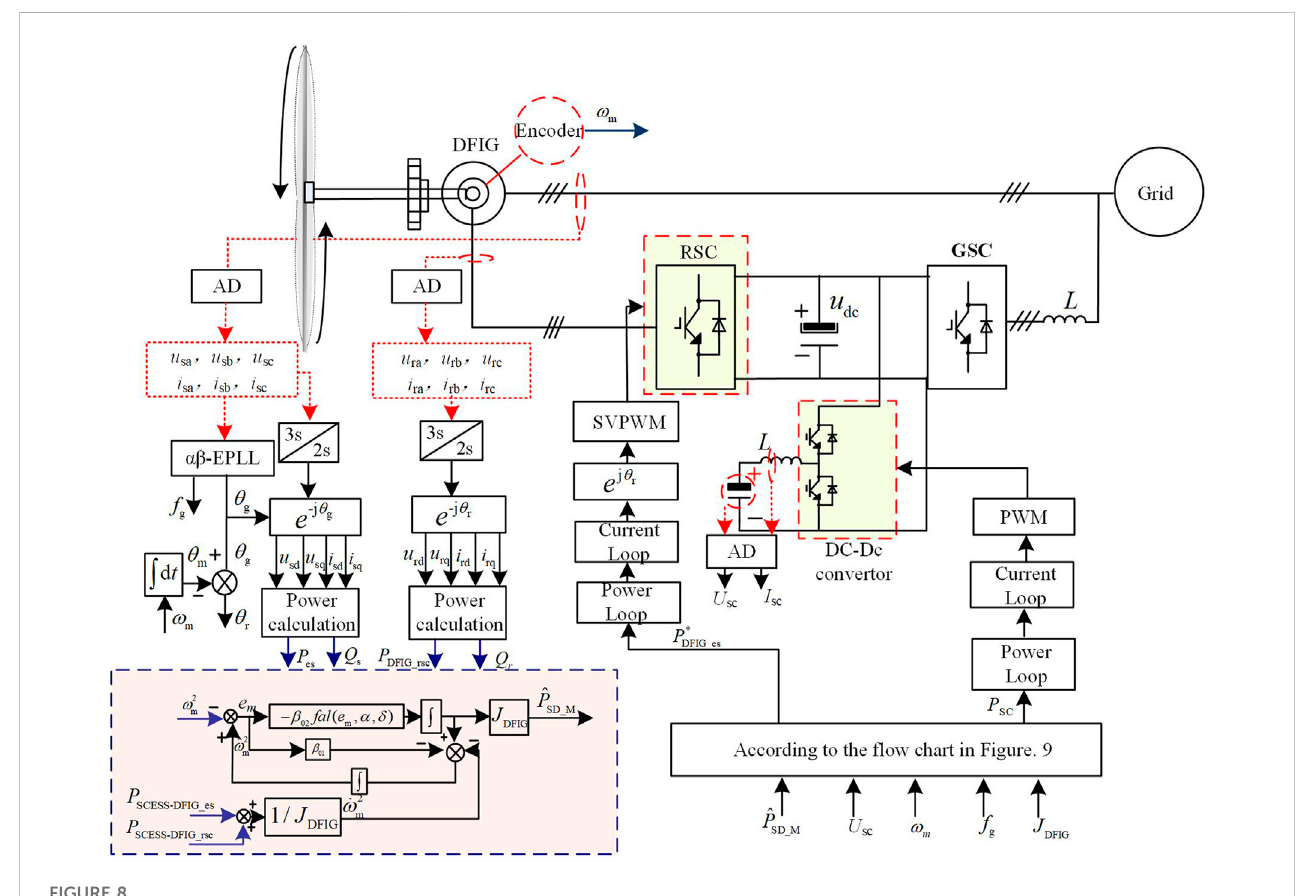
FIGURE 8 Control block diagram of RSC and DC-DC converter in